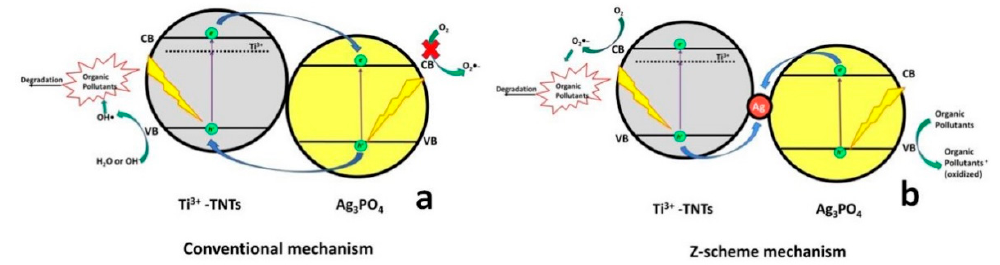
Figure 8. Photocatalytic mechanisms Ti 3+ -TNTs/Ag 3 PO 4 ( a ) conventional heterojunction, and ( b ) Z-scheme heterojunction.